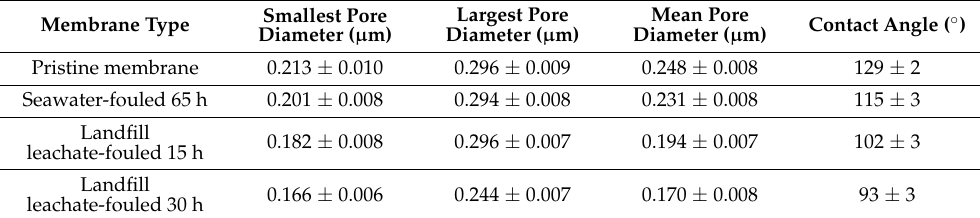
Table 4. Pore size and contact angle analysis of pristine and fouled